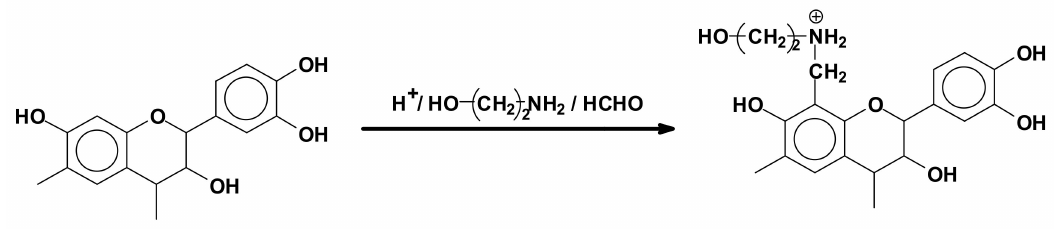
Figure 7. Reaction of ethanolamine and formaldehyde with a flavonoid tannin unit to form anpho-tannins used as industrial